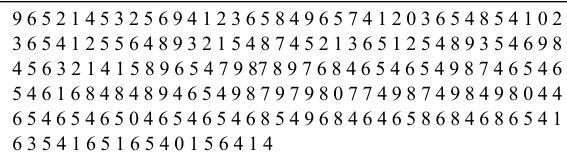
Table 3 - The results of control tests in children aged 15-16. Test Control group (n = 25) The experimental group (n = 27) Before After % p Before After Run 2000 m (min